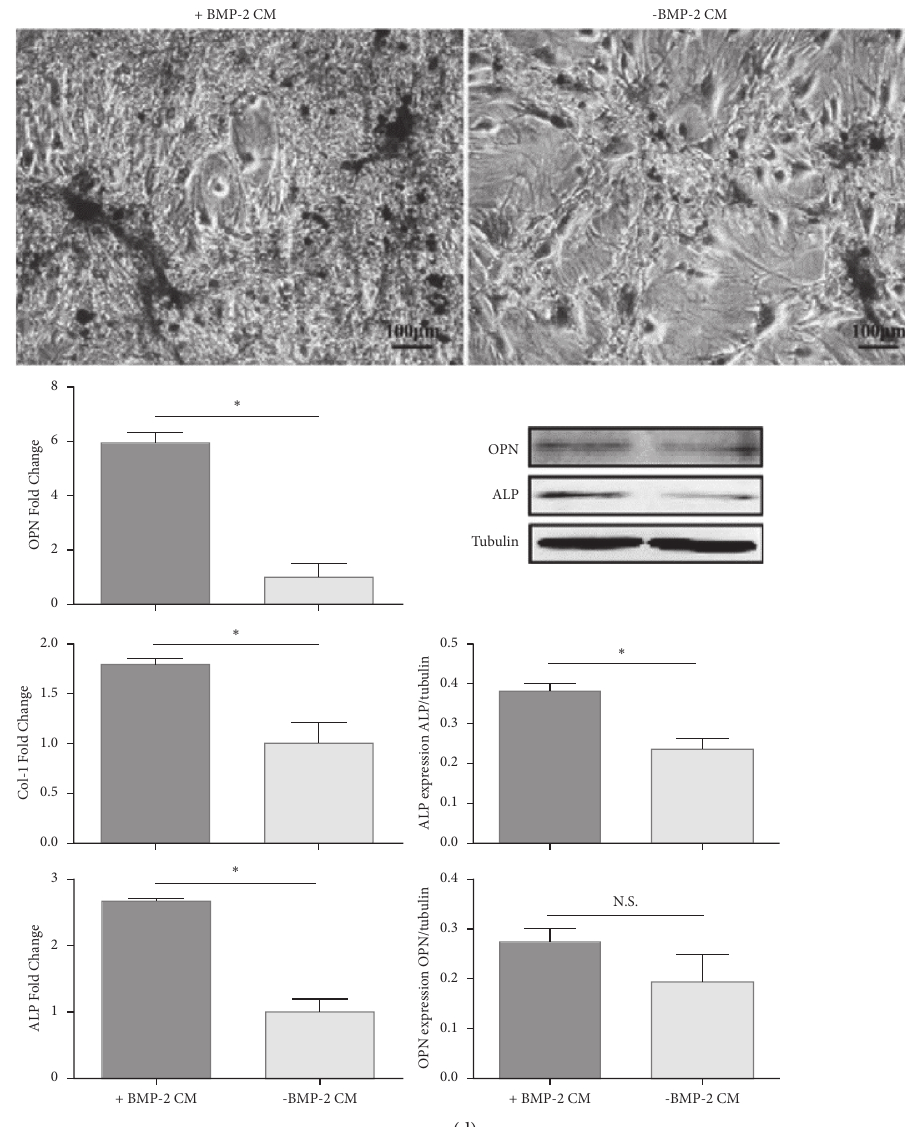
Figure 5: (a) Biomaterials regulate the inflammatory response of macrophages and its role in osteogenesis. (b) The western blotting analysis of OPN and ALP expression by BMSCs cultured in the culture medium (negative) and macrophage/scaffold conditioned medium [150] (Copyright 2104, Elsevier). (c) The quantification of the staining of OCN and Runx2 using ImageJ software and the expression of OCN analyzed by real-time PCR [156] (Copyright 2019, Biophysical Society). (d) Alizarin Red S staining of BMSCs treated with macrophage- derived conditioned medium (CM) (+BMP2 CM or − BMP2 CM) in the osteogenic differentiation condition for 21 days; gene expressions of ALP, OPN, and Col I detected by real-time PCR and representative western blots of ALP and OPN after BMSCs were cultured with macrophage-derived CM for 3 days [160] (Copyright 2018, Mary Ann Liebert